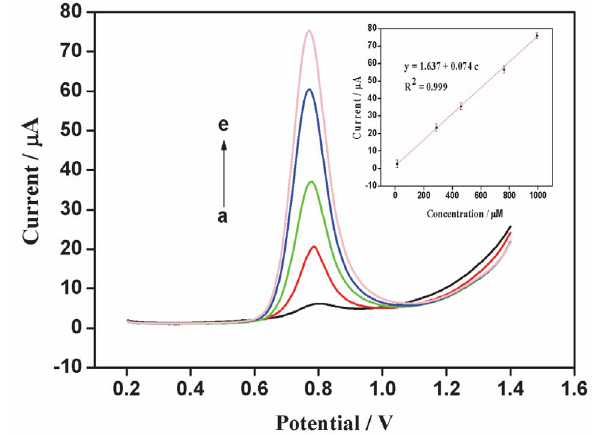
Fig 8. DPVs of nitrite with different concentrations on PEDOT/ Fe 3 O 4 -CNCC/GCE in PBS (0.2 M, pH 7.4) at a scan rate of 100 mV s -1 . The inset is the linear relationship between peak currents and concentrations of nitrite.